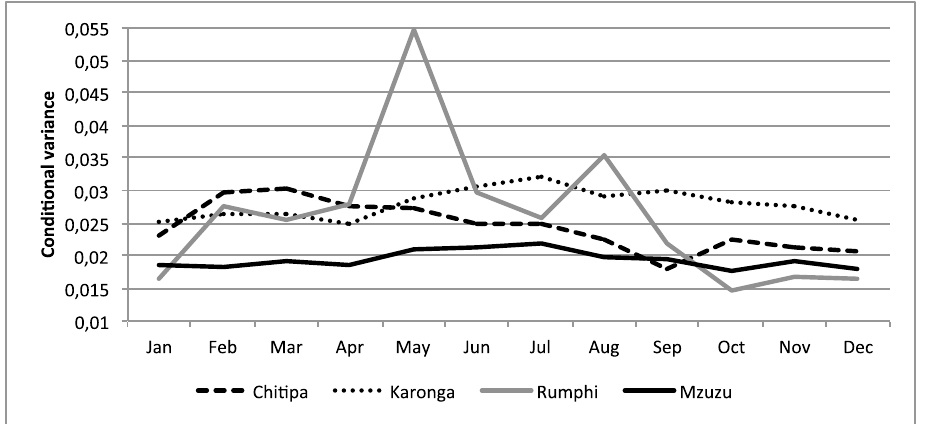
Figure 6. Yearly average conditional variance of the unpredictable component of maize price in the local-economy markets of northern Malawian region by month (January 1991-March 2013).